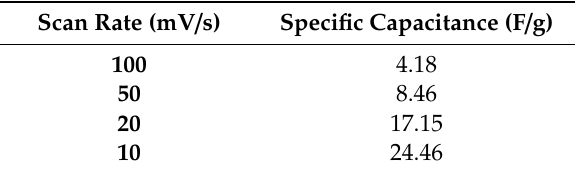
Table 6. Specific capacitance, C s of the EDLC at different scan rates.